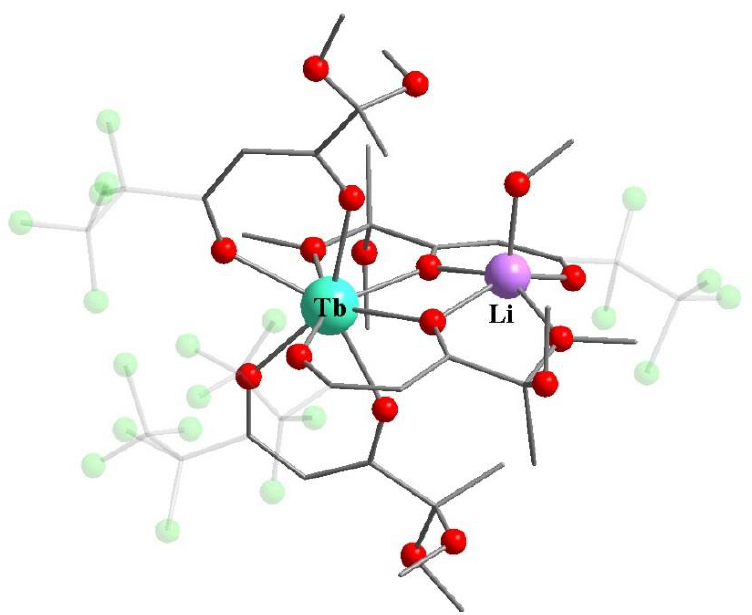
Figure 20. Molecular structure of 39 [89]. Hydrogen atoms have been omitted, C 2 F 5 groups are transparent for clarity. The cif has been retrieved from CCDC. CCDC numbers is 2011088.